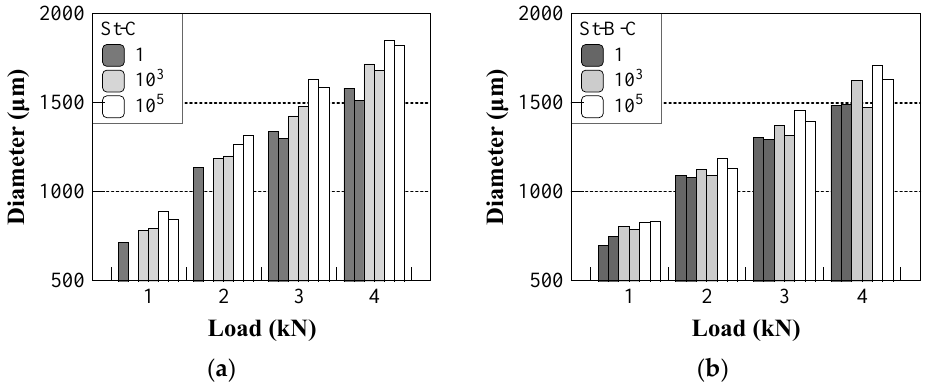
Figure 7. Impact diameters of St-C ( a ) and St-B-C ( b ) at different load cycles (1, 10 3 , 10 5 ) as a function of the applied load. The impact diameters for 1 load cycle for sample St-C could only be measured for one of the impacts due to their insignificance.